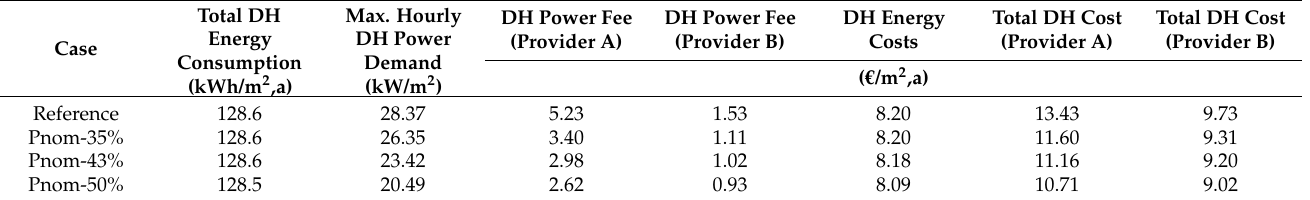
Figure 13. Temperature duration curves of the coldest room (namely, office room 8) for cases with different peak demand limiting during occupied hours. Table 7. DH energy and power demand and costs for reference and peak demand limiting